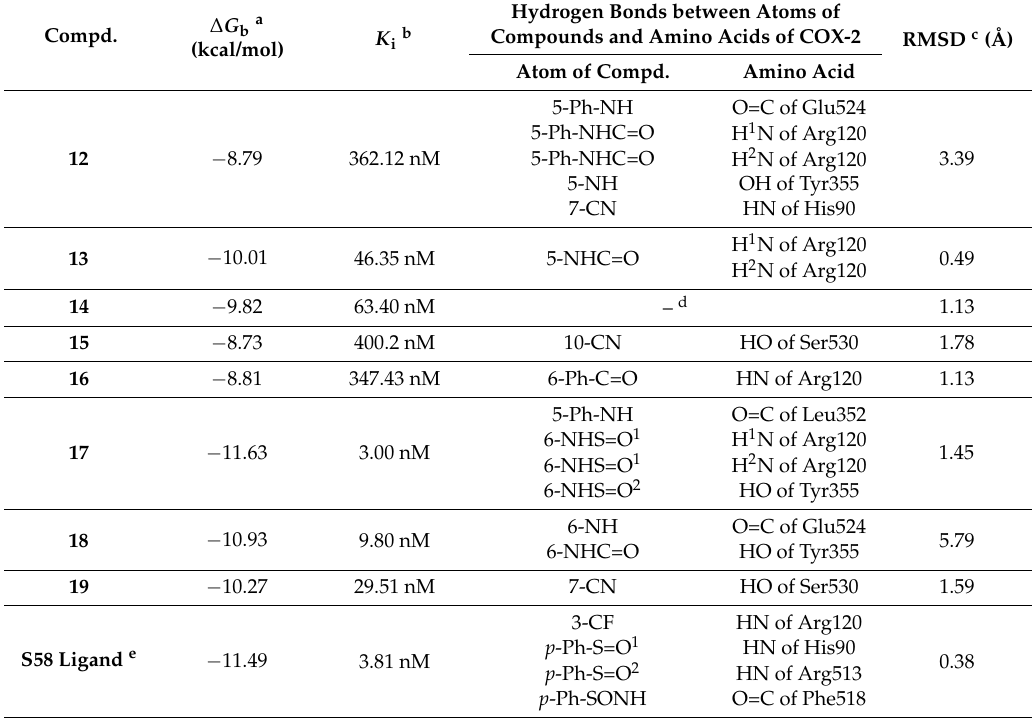
Table 4. Results of the flexible docking of compounds 12 – 19 into COX-2 (pdb: 1cx2) [35] in comparison to the native co-crystallized S58 ligand.